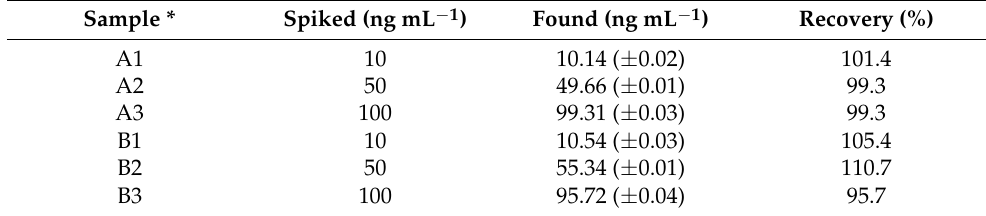
Table 1. Results for Mb detection in artificial plasma samples (A) and artificial urine samples (B) using the immunossensor.